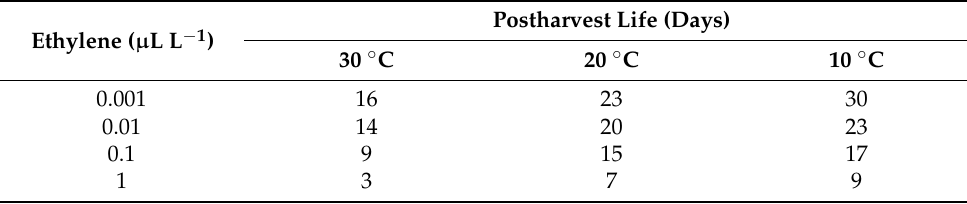
Table 3. Postharvest life of cucumber stored at 10, 20 and 30 °C in a range of ethylene concentrations.